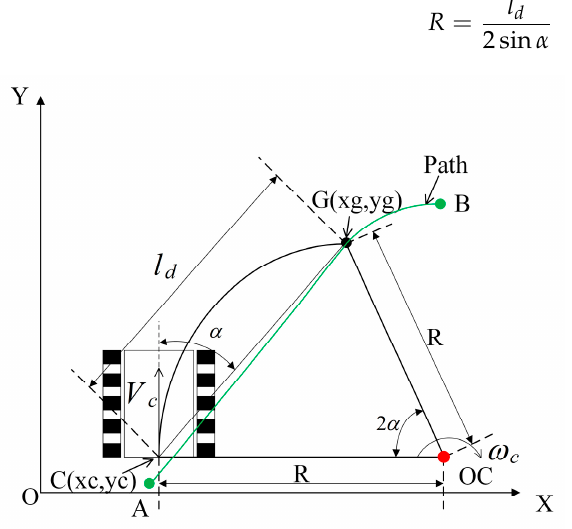
Figure 8. The pure pursuit model of the spraying robot.